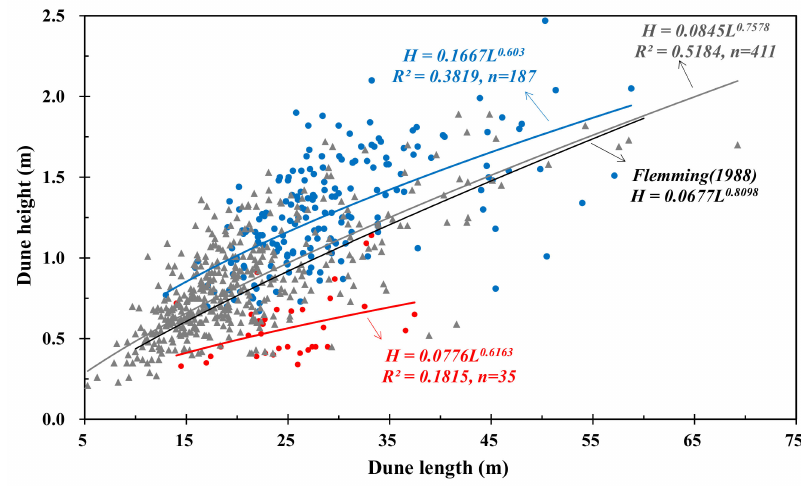
Figure 4. Relationship between length ( L ) and height ( H ) for the catenary-bead dunes (bedform developed in the catenary-bead dune area in flood season, blue line), the other dune type (bedform developed in the catenary-bead dune area in dry season, red line), other dunes in the YR estuary (gray line, locations see the MBES lines area in Figure 1b) and Flemming (1998) line.